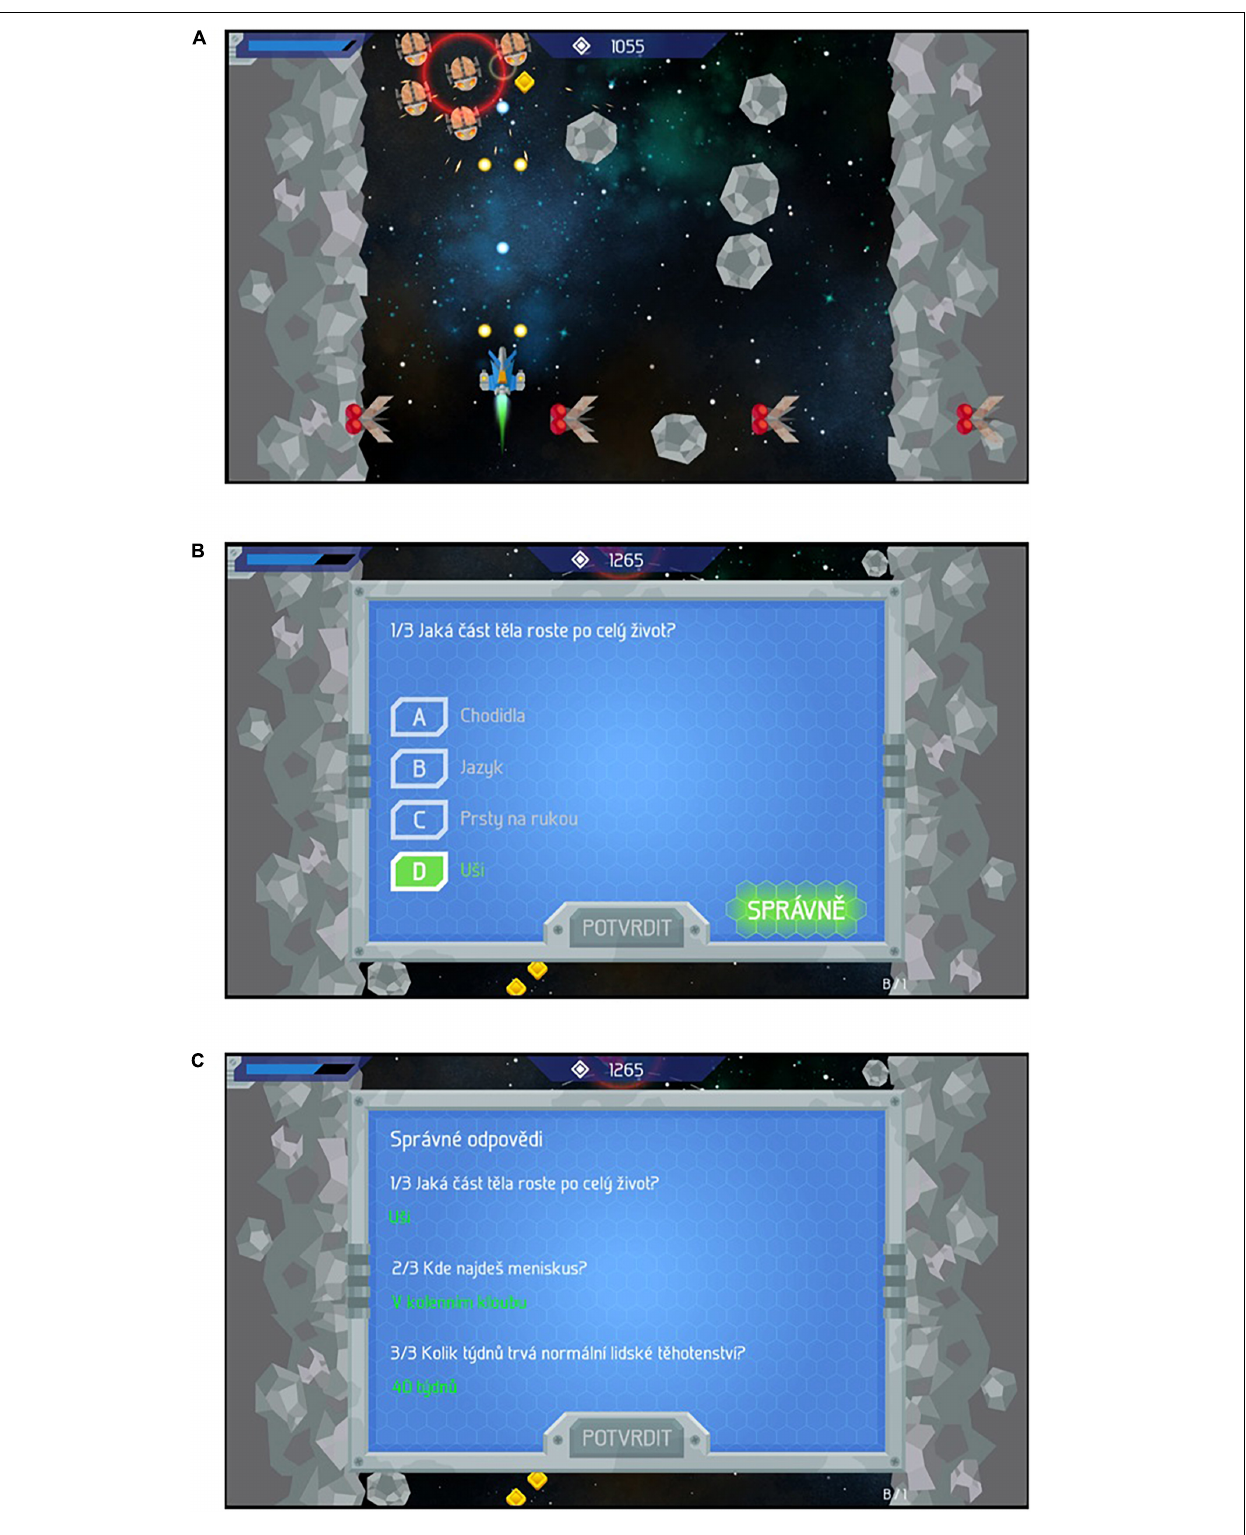
FIGURE 1 | (A) Screenshot from the game. The player controls the ship’s movements and he/she can shoot at the space rocks and at alien spaceships moving in the opposite direction. Top left: ship’s remaining “lives.” Top middle: Points. (B) Screenshot from the quiz depicting the correct answer; shown after an incorrect response. (C) Screenshot from the quiz: all three correct answers are listed after the given trio of questions has been completed. The same graphics are used for the in-game as well as the bare quiz questions. The texts are in the Czech language. [Courtesy of Czech Television (c)].